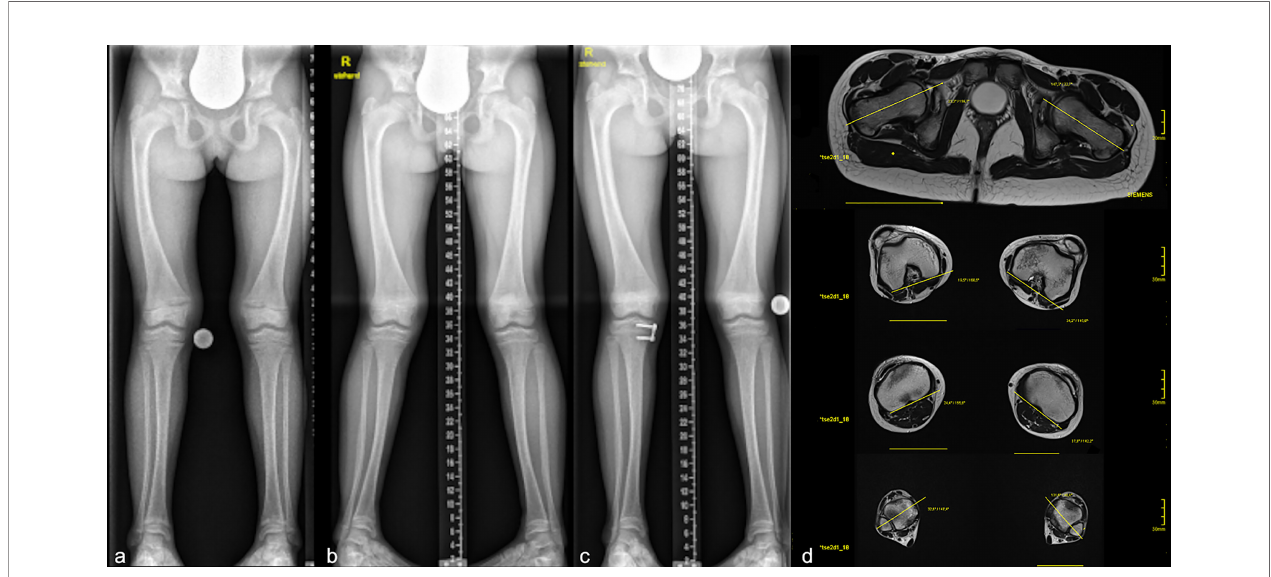
FIGURE 5 | Case 2: Radiographs (A-C) and torsional MRI (D) of a 10-year-old girl undergoing Burosumab therapy. Full long leg standing radiographs were obtained prior (A) to Burosumab initiation and during treatment. Lateralization of MAD in one leg was observed at the 10-month follow-up (B) . Guided growth procedure using temporary hemiepiphysiodesis was performed on the right tibia with short term success 6 months postoperative (plate not yet removed) (C) . Torsional MRI showed 2° internal torsion of the femur and 3° external torsion of the tibia (D) .